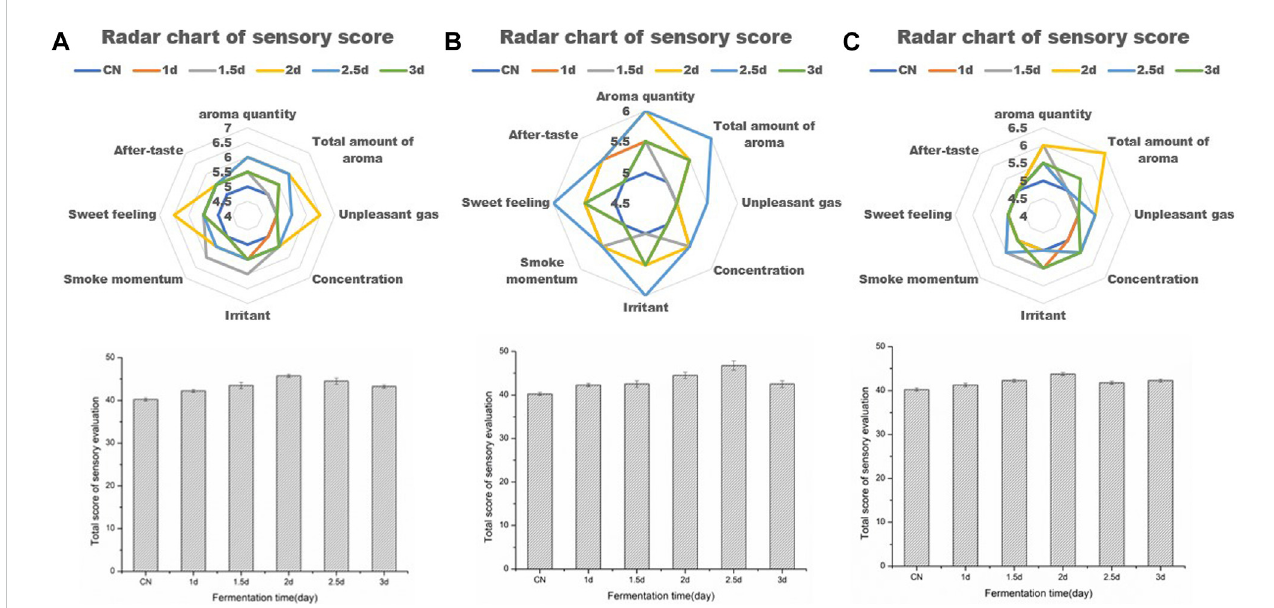
FIGURE 5 Sensoryevaluationresultsoftobaccoleavesfermentedwithfunctionalstrainsfordifferenttimeperiods (A) .Optimizationoffermentationdayswithstrain 44# (B) . Optimization of fermentation days with strain 3# (C) . Optimization of fermentation days with strain F7#.